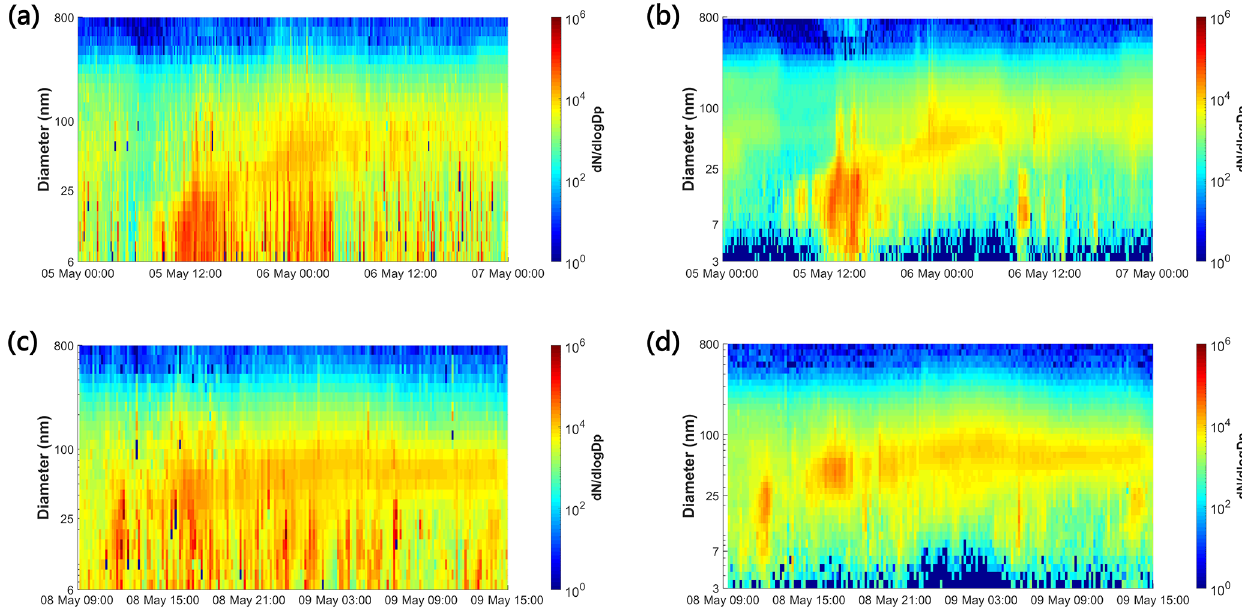
Figure 7. Time series of particle size distribution at the background station (b, d) and at street canyon site (a, c) measured by DMPS for periods of 5 May–7 MayLT (a, b) and 8 May 09:00LT–9 May 2018 15:00LT (c, d)